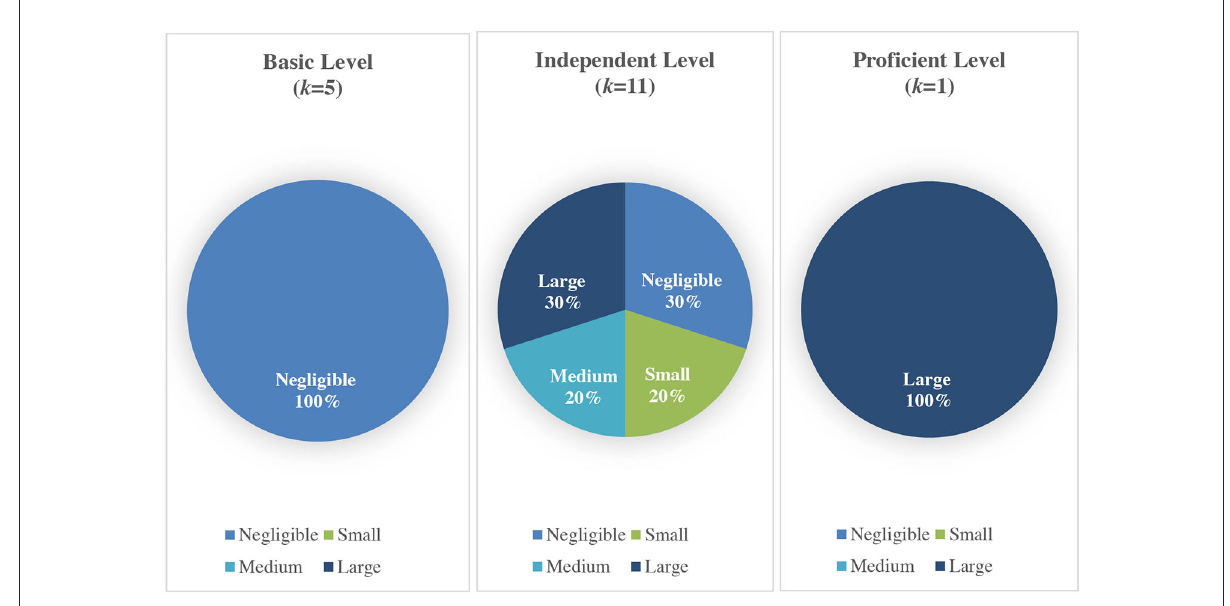
FIGURE6 Effect size plot for proficiency level of learners ( k